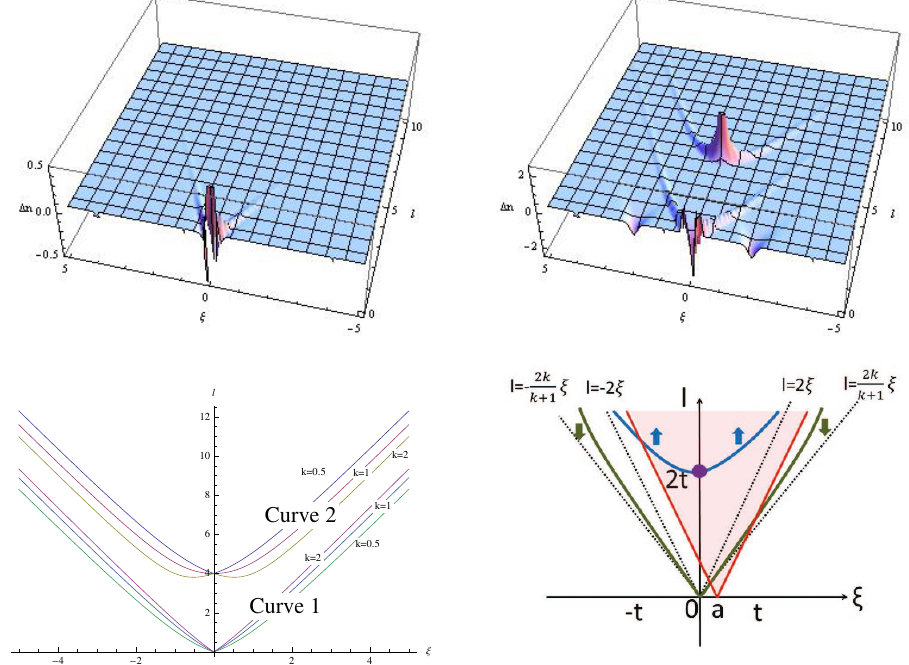
Figure 10 . The behaviors of a smeared entanglement density (ED) for the holographic splitting local quench. The upper left and right graph are the plots of (cid:1) n ( (cid:24); l; t ) at t = 0 and t = 2, respec- tively with (cid:11) = 0 : 1 (again we set T BCFT = 0). The horizontal and depth coordinate corresponds to (cid:24) and l , respectively. Here we smeared the originally delta functional behavior of the ED by replacing the second derivatives w.r.t. l and (cid:24) with (cid:12)nite-di(cid:11)erences (cid:14) = 0 : 2. We observe delta functional behaviors on the two curves (4.18) and (4.19) at k = 1. The lower left picture shows these two curves at t = 2 for k = 0 : 5 ; 1 ; 2. The lower right picture describes the calculation of S A for a (cid:28) t (cid:28) b by integrating the ED over the red region. The green and blue curves represent curve 1: (4.18) and curve 2: (4.19). We (cid:12)nd that the blue curve gets into the red region, while the green curve goes out. The cancellations between them leads to the absence of logarithmic